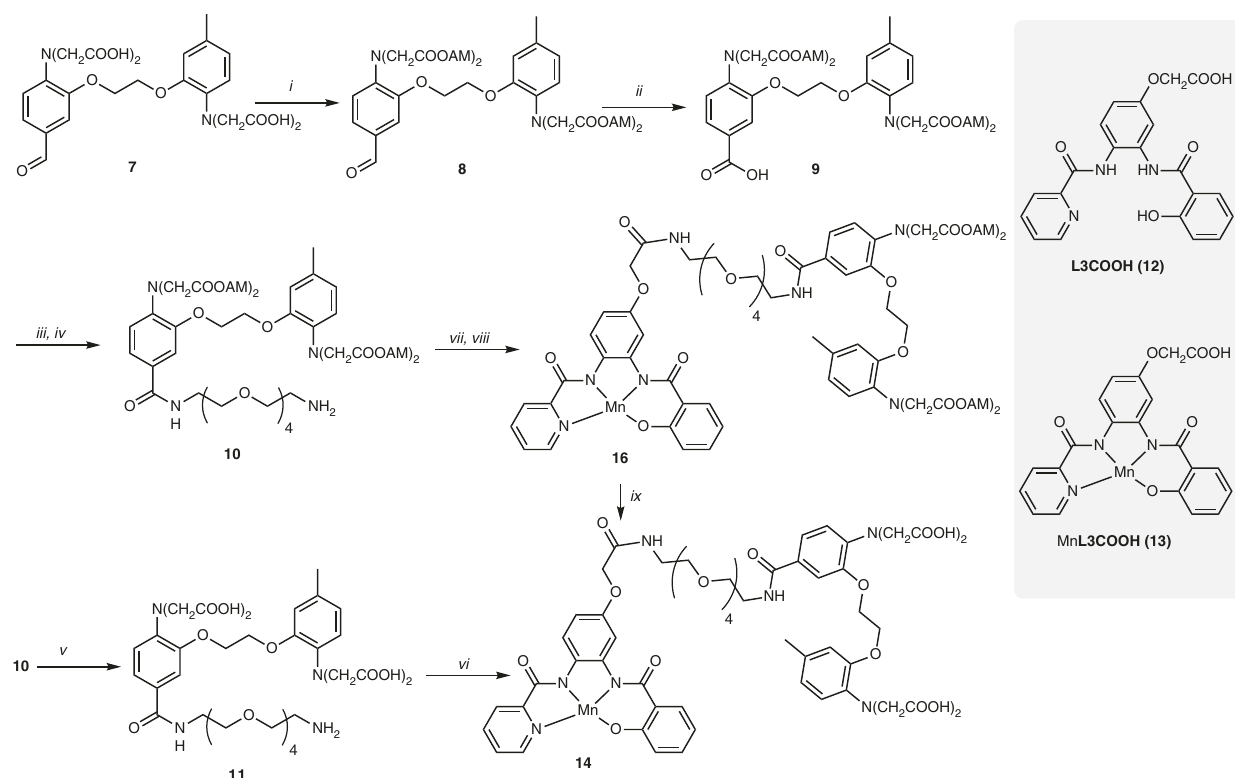
Fig. 2 Synthesis of ManICS1 and ManICS1-AM. i ) AcOCH 2 Br, DIEA (67%); ii ) NaH 2 PO 4 , NaClO 2 (95% yield); iii ) PyBOP, DIEA, NH 2 -PEG 4 -NHBoc (63%); iv ) TFA, DCM (98%); v) NaOH (6 eq), H 2 O (77%); vi ) Mn L3COOH ( 13 ), HATU, DIEA (33%); vii ) L3COOH ( 12 ), PyBOP, DIEA (67%); viii ) Mn(OAc) ix ) 10% (v/v) cell lysate, MOPS (25 mM, pH 7.9). Additional details described in Supplementary Methods 3 .2(H 2 O) (77%);